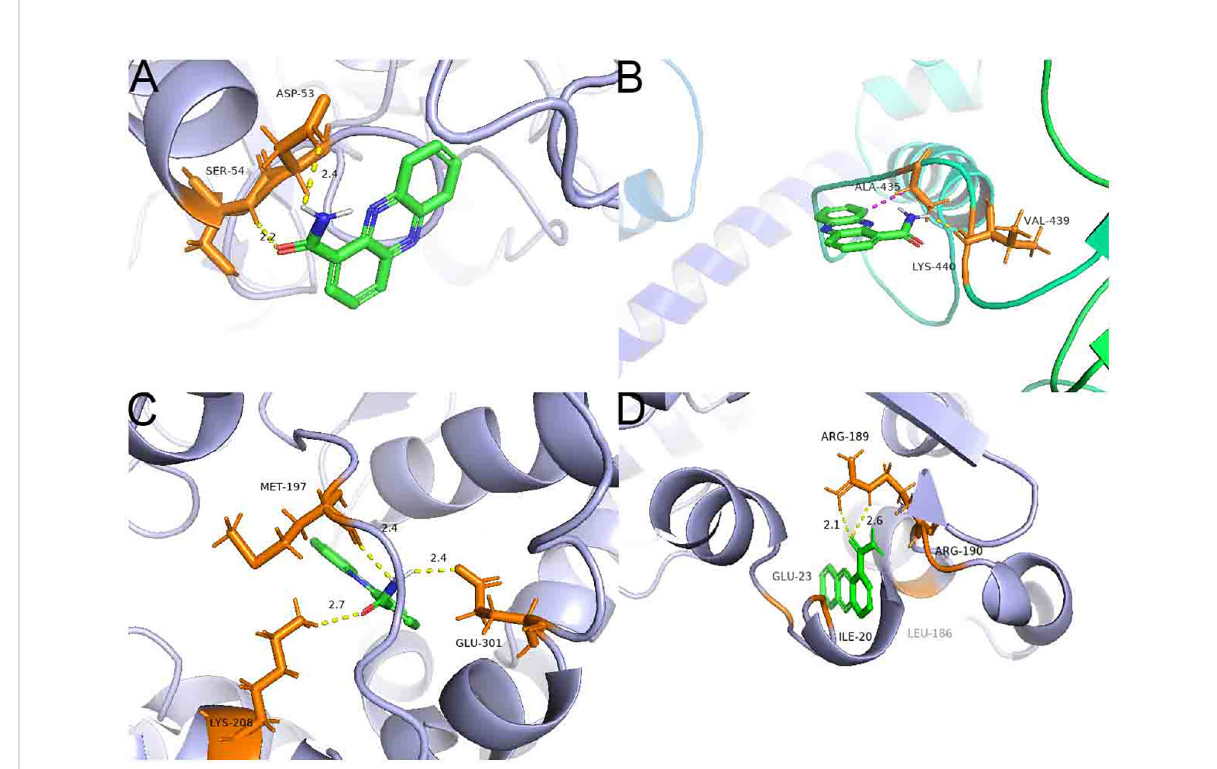
FIGURE 11 Binding complexes of PCN with key receptors in R. solani AG1IA. (A) NADPH nitrite reductase; (B) ATP-binding cassette transporter; (C) alpha/ beta hydrolase family domain-containing protein; (D) NADPH – cytochrome P450